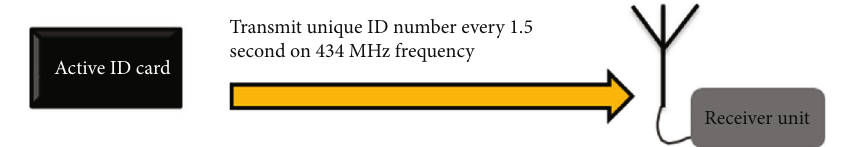
Figure 3: Active ID card transmits a unique ID number to the receiver unit.